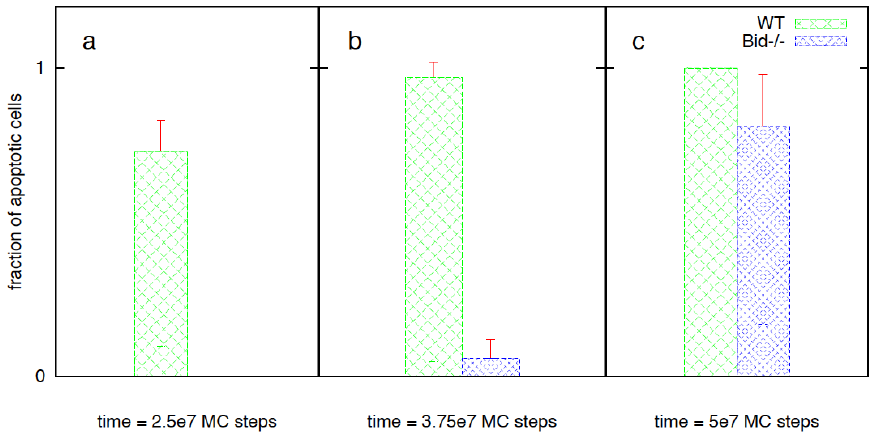
Figure 7. Single cell caspase 3 activation with concentration of Apaf reduced to 20 nM ( a